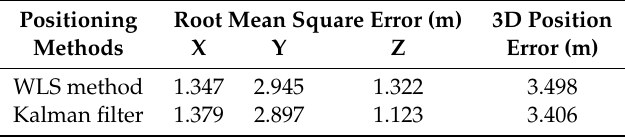
Figure 8. Result of standard point positioning on the three axes: ( a ) positioning error of weighted least square method; and ( b ) positioning error of Kalman filter. Table 1. Positioning errors of the two